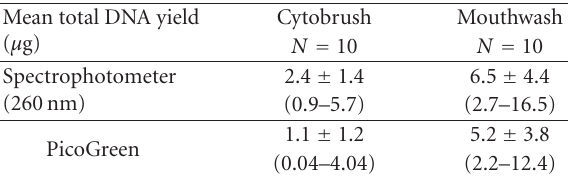
Table 2. Comparison of DNA amounts in µ g, obtained from 10 subjects with two di ff erent methods of quantification (ab- sorbance at 260 nm or fluorescence protocol with PicoGreen).